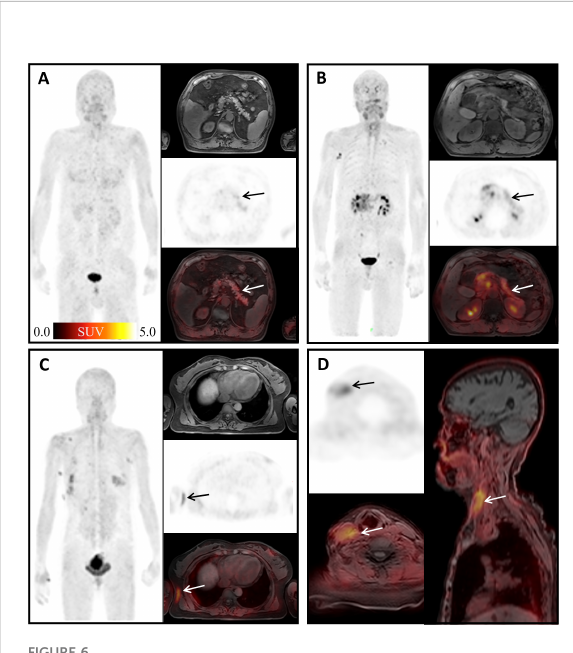
FIGURE 6 Physiological uptake of 68 Ga-FAPI-04. (A) A 67-year-old man with mucinous adenocarcinoma of the right lung 1 year after surgery; arrows show pancreatic diffuse in fl ammatory uptake, SUV max =4.66. (B) A 63-year-old man diagnosed with duodenal malignancy; arrows show obstructive pancreatitis, SUV max = 18.11. (C) A 49-year-old woman, 3 months after surgery for early microin fi ltrating adenocarcinoma of the right middle lobe and 2 months after surgery for left breast fi broma; arrows show surgical scar on the right chest with SUV max =3.89. (D) An 83- year-old woman diagnosed with gastric cancer 6 months ago; arrows show deep vein catheterization area of the right neck with SUV max